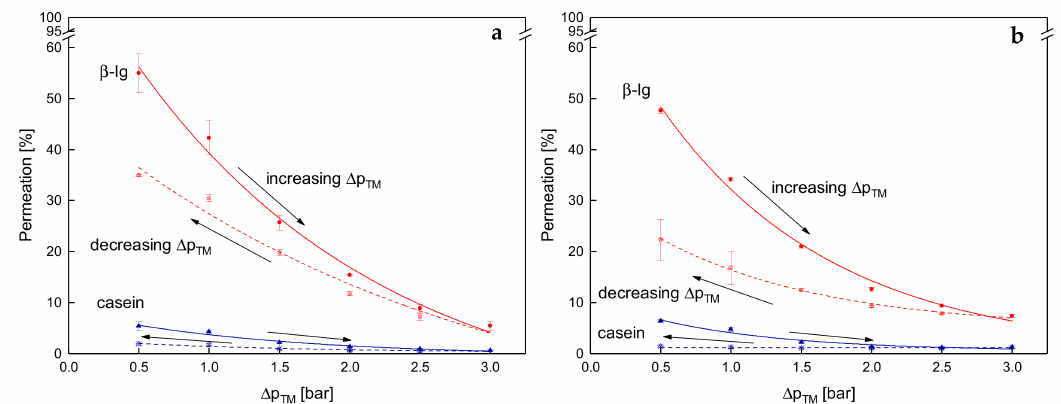
Figure 10. Permeation of β -lg (circles) and casein (triangles) as a function of ∆ p TM for one cycle of a stepwise increase of ∆ p TM (filled symbols and solid lines) and the subsequent stepwise reduction of ◦ C ( a ) and 50 ◦ C ( b ). Error bars represent the standard ∆ p TM (blank symbols and dashed lines) at 10 deviation of the permeation values of two individual experiments with milk from two di ff erent